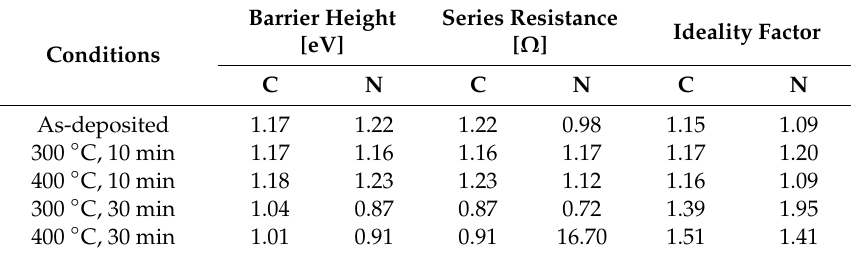
Figure 6. Summarized plot of the parameters of prepared Schottky diodes using the Cheung and Cheung method and the Norde method: ( a ) barrier height; ( b ) Series resistance; and ( c ) ideality factor. Table 2. Summarized device parameters of prepared Schottky diodes.